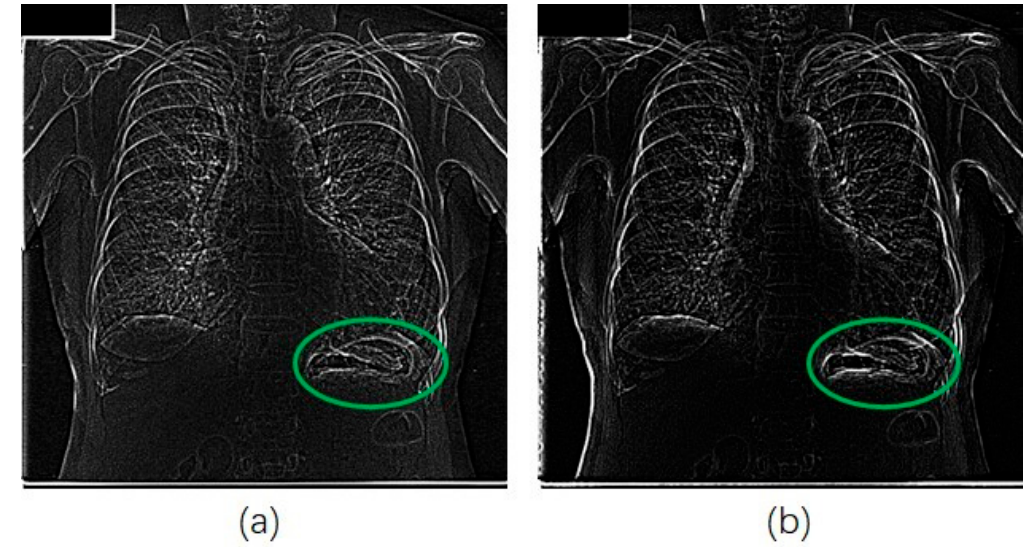
Figure 7. An image from Japanese Society of Radiological Technology (JSRT) database.